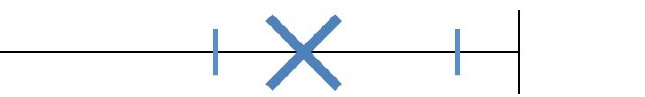
Figure 2. Example of an answer collected from a writing form using a fuzzy rating